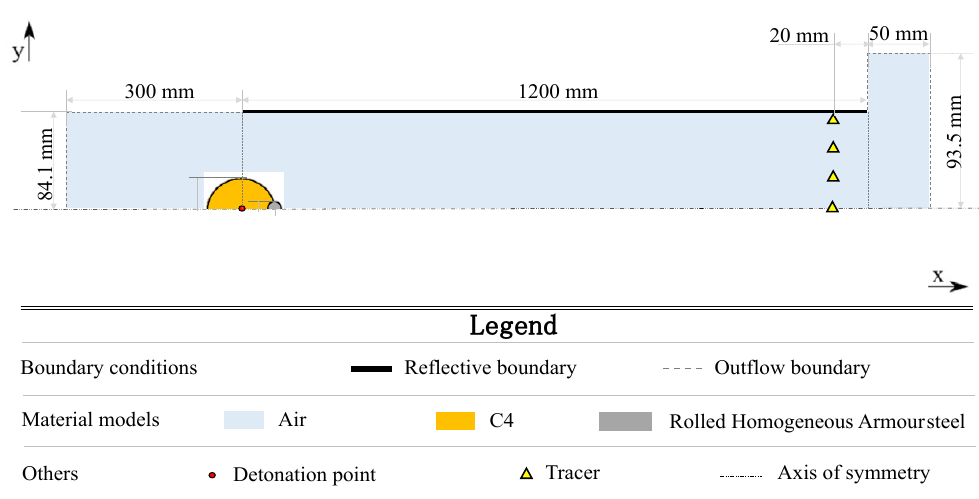
Figure 15. Schematic representation of the 2D axi-symmetric model in LS-DYNA: geometry, dimen- sions, materials, and boundary